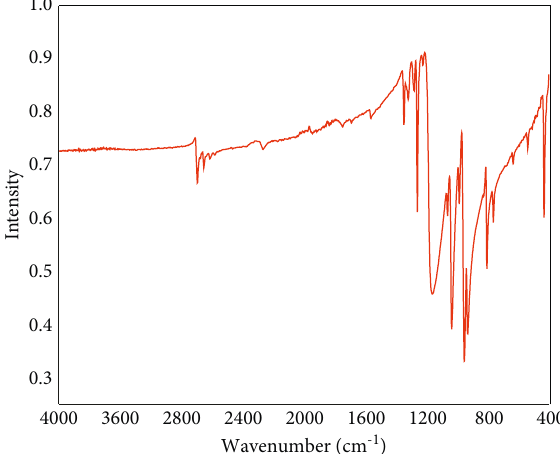
Figure 3: IR spectrum of the NiEtX